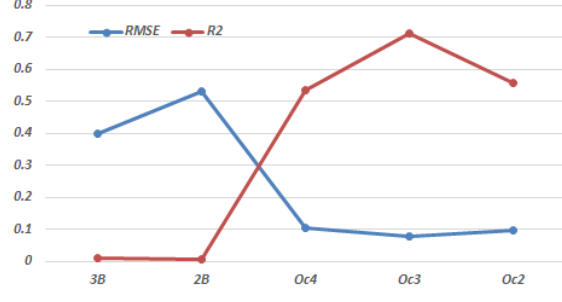
Figure 4 . Comparison of performance of different algorithms As it clear form OC3 algorithm, the largest amount of R 2 (0.713) and the lowest RMSE (0.077) is the most appropriate algorithm in the desired area. Finally, new coefficients for algorithm using Landsat8 data sets for study area are achieved (Eq 5).